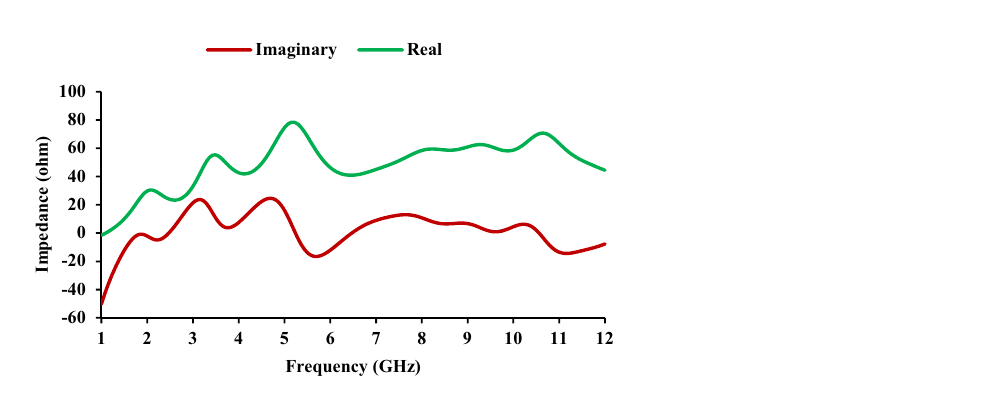
Figure 5. Impedance characteristics of the antenna